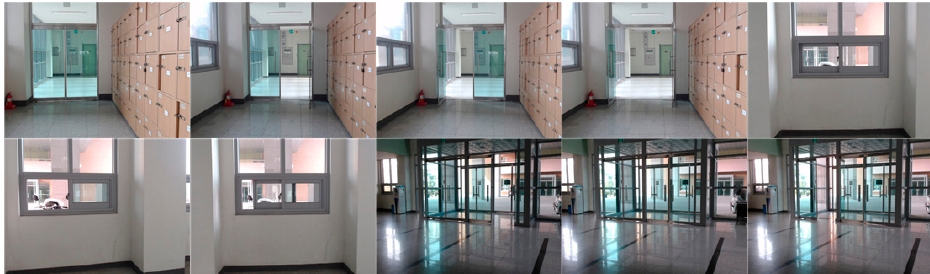
/ closed of door and window. Figure 8. Images of opened/closed of door and window. Figure 8. Images of opened